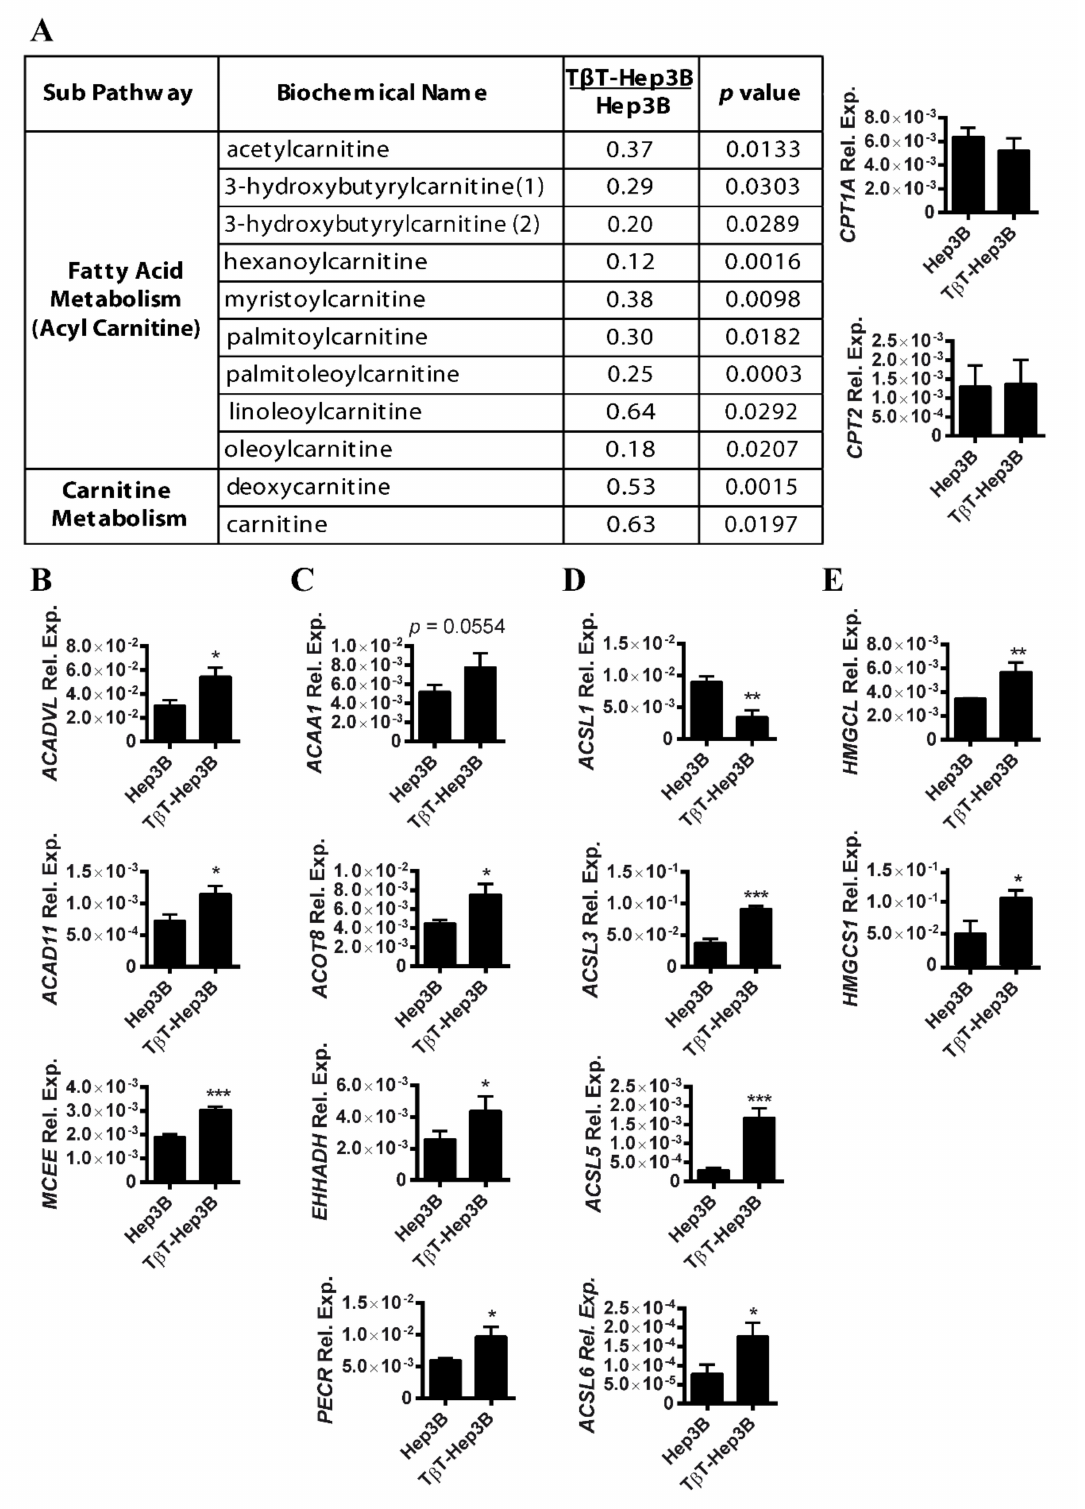
Figure 3. Decrease in carnitines and acyl carnitines in T β T-Hep3B correlates with an increased expression of β -oxidation genes. ( A ) Left: metabolites of carnitine pathway of T β T-Hep3B compared to Hep3B presented in fold. Welch’s two-sample t -test was used to identify biochemicals that differed significantly between experimental groups ( n = 5 for each group, p value indicated in the right column). Right: expression of CPT1A and CPT2 . Mean ± SD ( n = 3). ( B – E ) Expression of genes related to mitochondrial β -oxidation ( B ), peroxisomal β -oxidation ( C ), ACSL family members ( D ) and ketogenesis ( E ). Mean ± SD ( n = 3). * p < 0.05, ** p < 0.01, *** p <